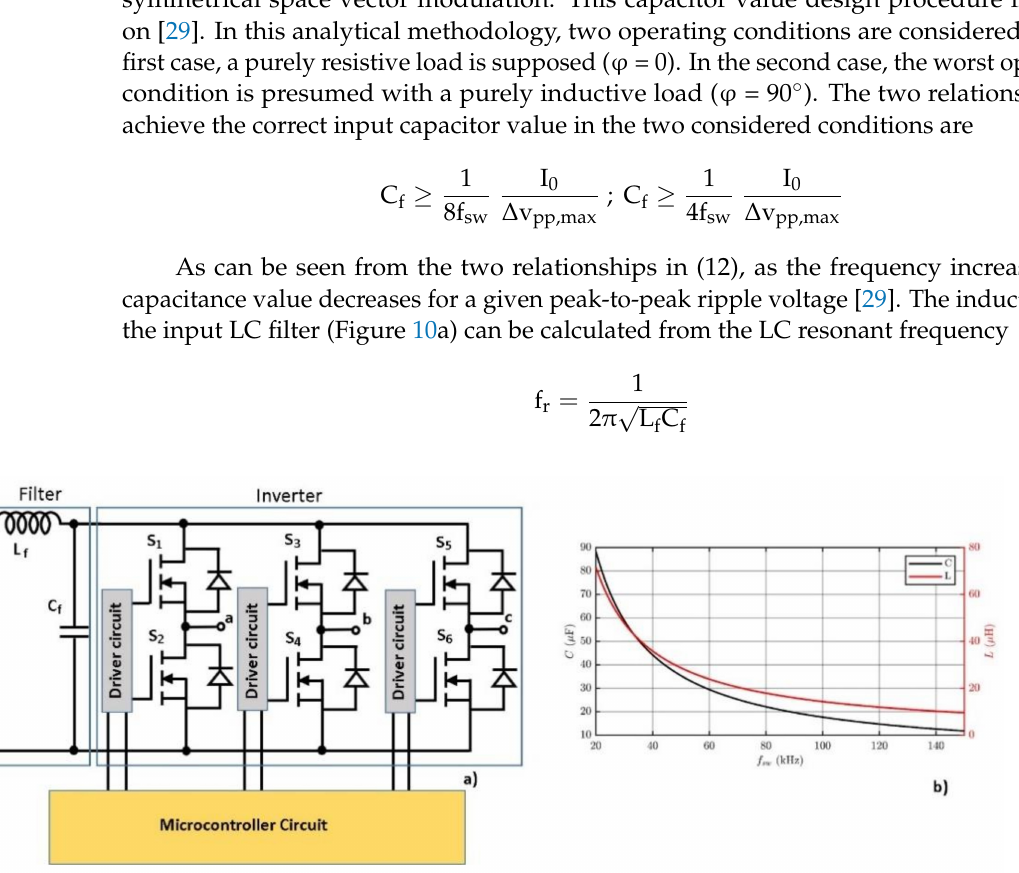
Figure 10. ( a ) Simplified low-pass filter schematic in the input side of the battery-powered inverter; ( b ) graphic of the passive component of the filter versus the switching